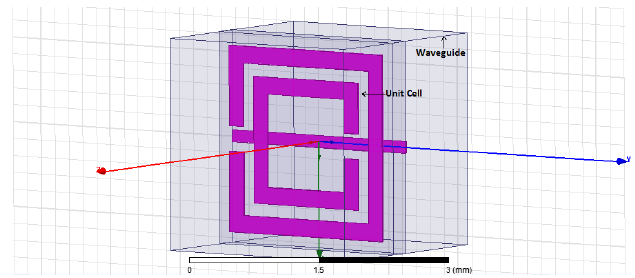
Figure 1: Unit cell in